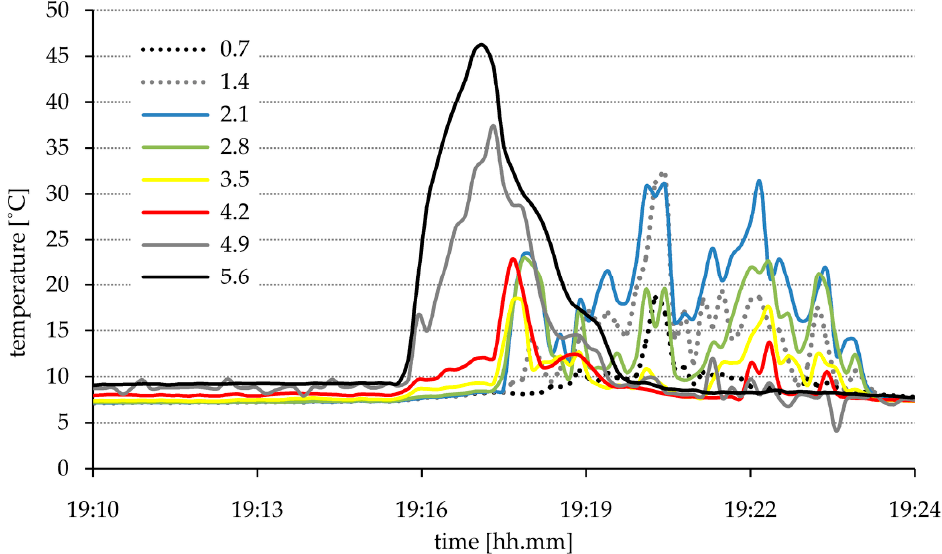
Figure 7. Temperature distribution on windward at 5 m from the last tray. The height of a measuring point is given in meters.